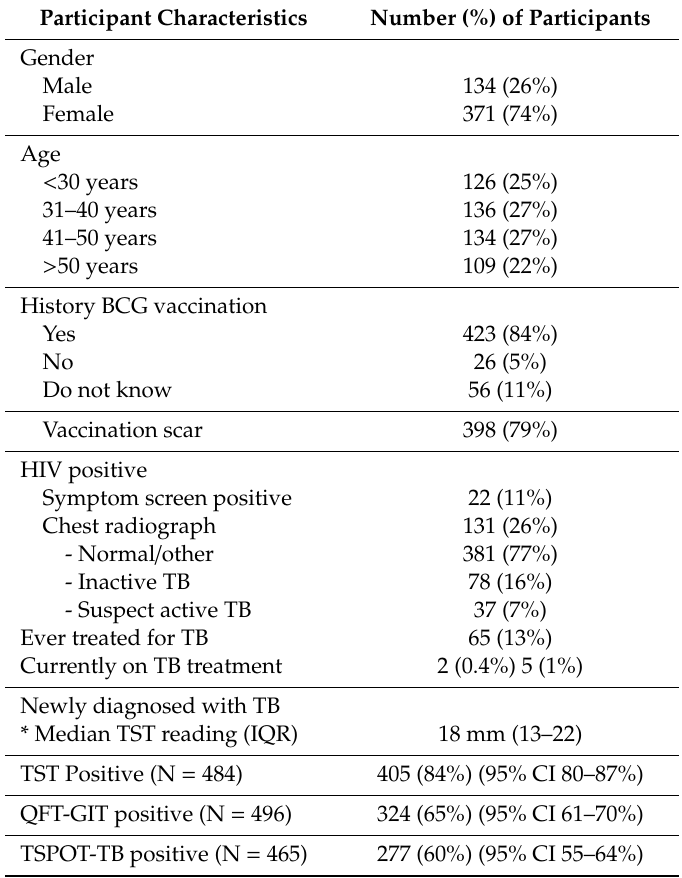
Table 2. Demographic characteristics and test results of participants (N = 505).